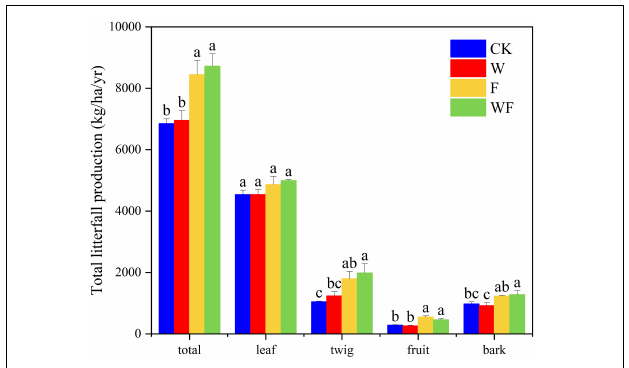
Figure 2 | Total litterfall production and components (kg/ha/yr) of E. urophylla × E. grandis from August 2019 to July 2020. The bars in different colors, respectively, indicated CK, W, F, and WF treatment. The error bars indicated SE. The values followed by the different letters are significantly different according to one-way ANOVA ( P < 0.05).